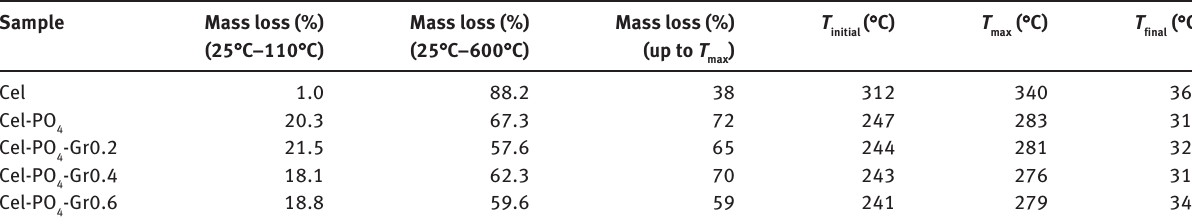
Table 1: TGA data for the samples.